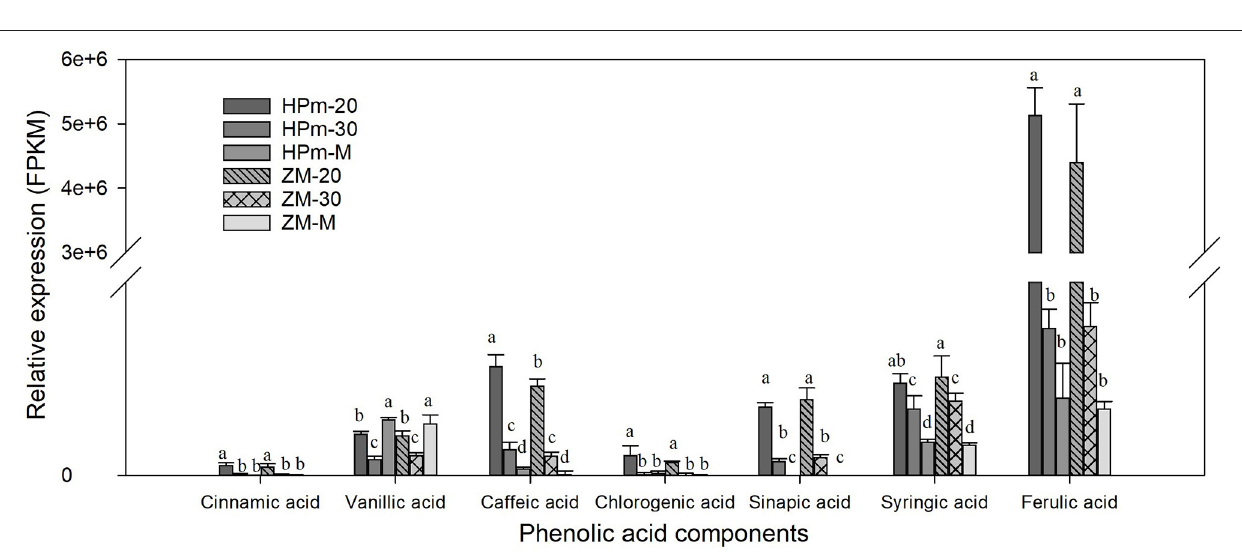
FIGURE 2 | Relative expression levels of identified phenolic acids in wheat grains during grain filling. HPm-20, HPm-30 and HPm-M are samples from wheat cultivar HPm512 at 20 days after anthesis (DAA), 30 DAA, and maturity, respectively. ZM-20, ZM-30, and ZM-M are samples from wheat cultivar ZM22 at 20 DAA, 30 DAA, and maturity, respectively. The different lowcase letters above the column within the same phenolic acid indicate a significant difference ( P <